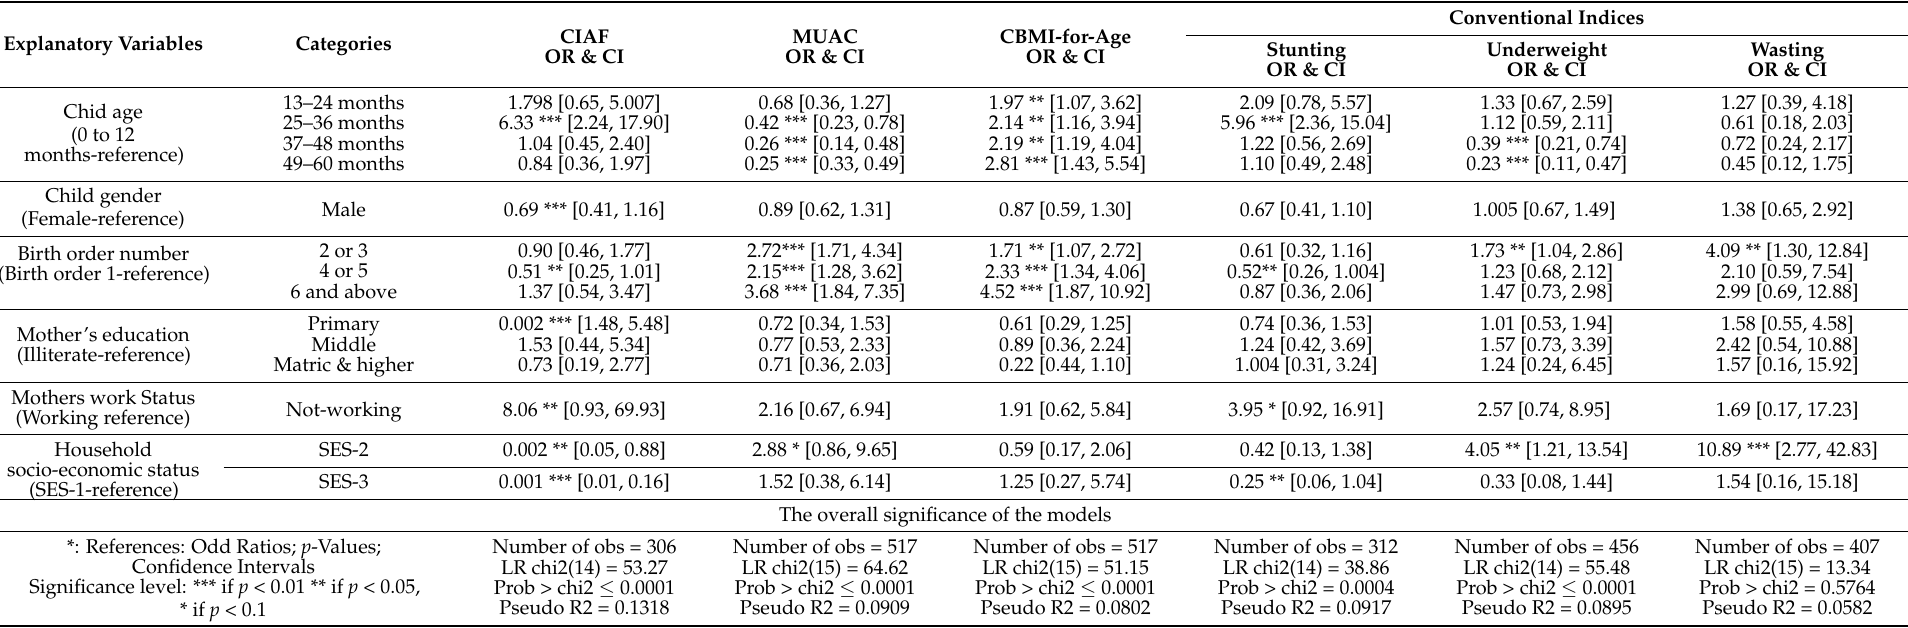
Table 4. Binary logistic regression analysis results for CIAF, MUAC, Child BMI-for-age, Conventional Indices, and their